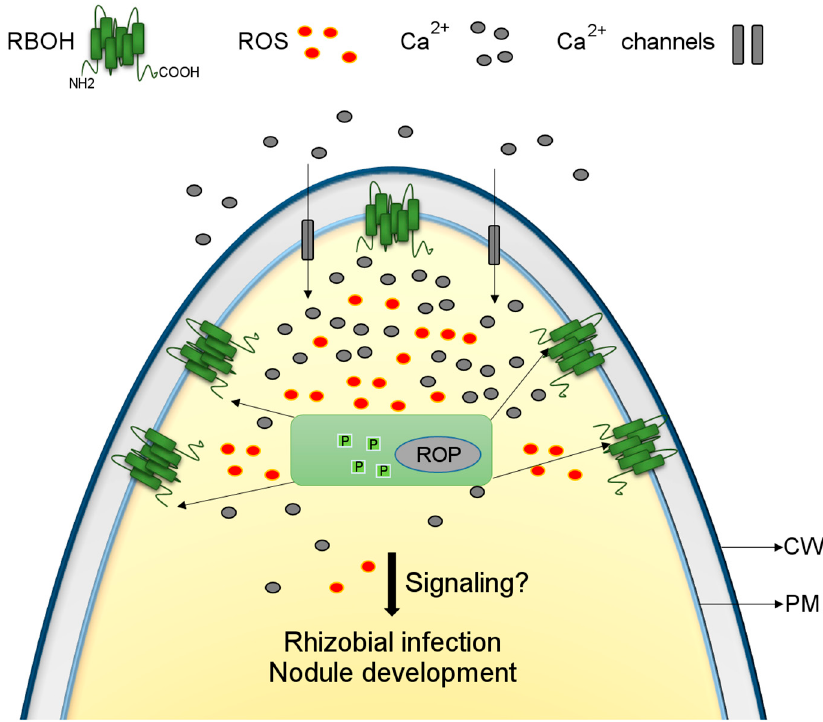
Figure 1. Scheme of the early symbiotic signaling pathway after nodulation factor (NF) recognition by root hairs. NF induces a transient increase in respiratory burst oxidase homologues (RBOH)-dependent reactive oxygen species (ROS) production and cytoplasmic calcium concentration in the apical region of legume root hairs. RBOH activity is presumably regulated by Rho-like GTPases from plants (ROP GTPases) and phosphorylation at its N-terminus. ROS produced by RBOH activation likely act as signaling molecules that mediate rhizobial infection and nodule development. CW, cell wall; PM, plasma membrane.